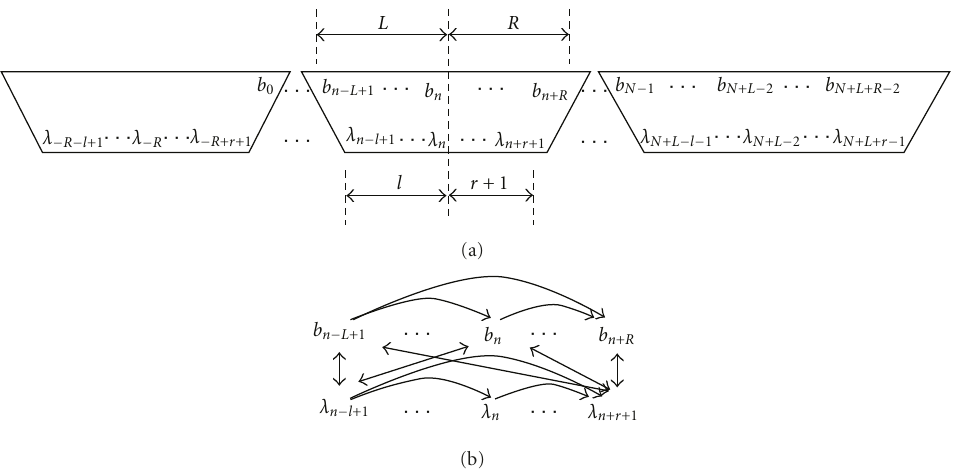
Figure 1: (a) sliding-window association (clique) of observations and hidden states in the metastate hidden Markov model, where the clique-generalized HMM algorithm describes a left-to-right traversal (as is typical) of the HMM graphical model with the specified clique window. The first observation, b 0 , is included at the leading edge of the clique overlap at the HMM’s left boundary. For the last clique’s window overlap, we choose the trailing edge to include the last observation b N − 1 . (b) graphical model of the clique- generalized HMM, where the interconnectedness on full joint dependencies is only partly drawn. The graphical model is significantly constrained, as well, in a manner not represented in the graphical model, in that state sequences are only allowed with at most one nonself transition.